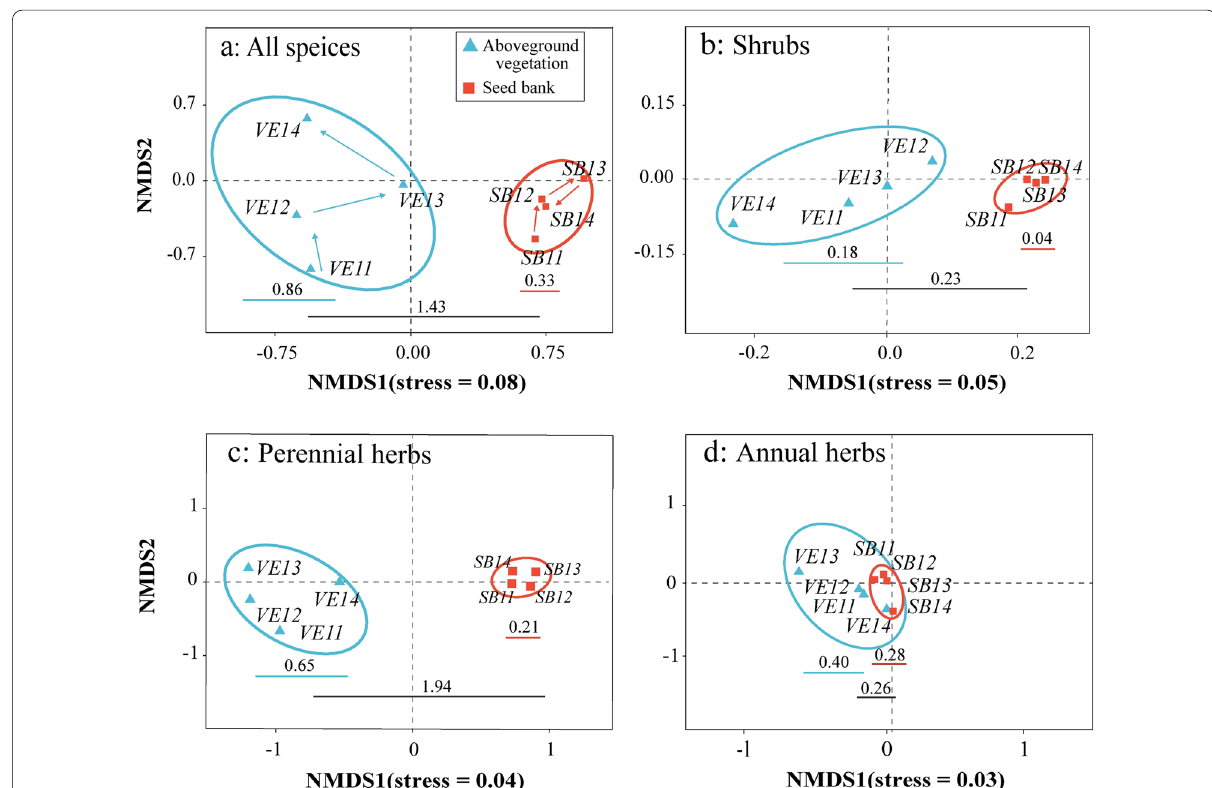
Fig. 3 NMDS ordination of the species composition of the aboveground vegetation (VE11‑14) and soil seed bank (SB11‑14) for all the quadrats as a whole in four measured years (2011–2014). Shown are a all species; b shrub species; c perennial herb species; d annual herb species. The location of ordination points within each diagram indicate the degree of similarity between each one in the first two axes of NMDS. Colored ellipses represent different species groups based on 85% level confidence intervals. In figure a, arrows represent the temporal change of the ordination points of the soil seed bank and aboveground vegetation. The ordination distances within the aboveground vegetation, the seed bank, and between these two groups are shown in values above the different line segments, respectively. The length of line segments represent the relative magnitude of ordination distance for each group. The detailed statistics results about the ordination distances are listed in Table 2